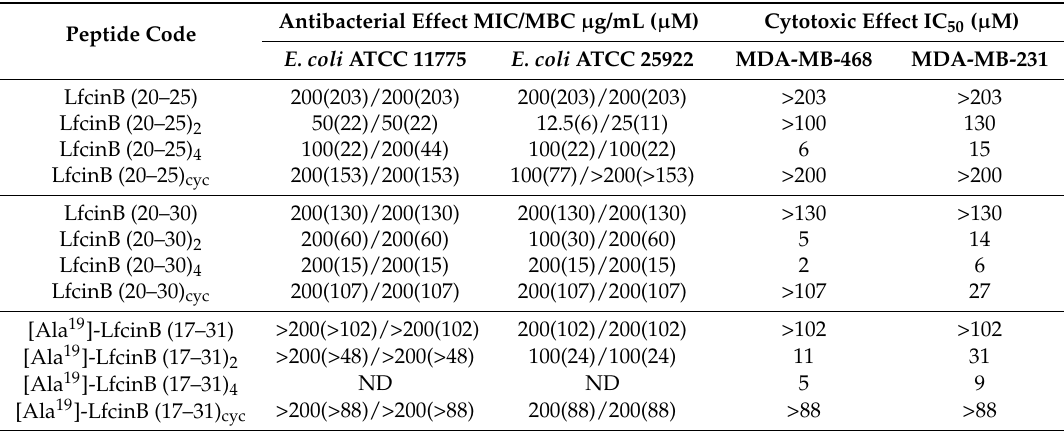
Table 2. LfcinB-derived peptides’ biological